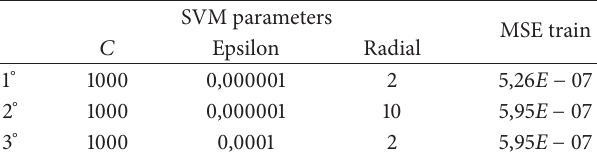
Table 4: Setting of SVM parameters: samples with low concentra- tion.